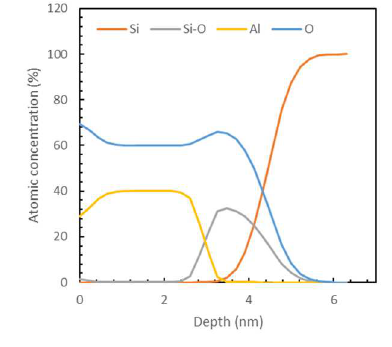
Figure 3 : ARXPS reconstructed composition profile of a Al 2 O 3 /SiO 2 /Si